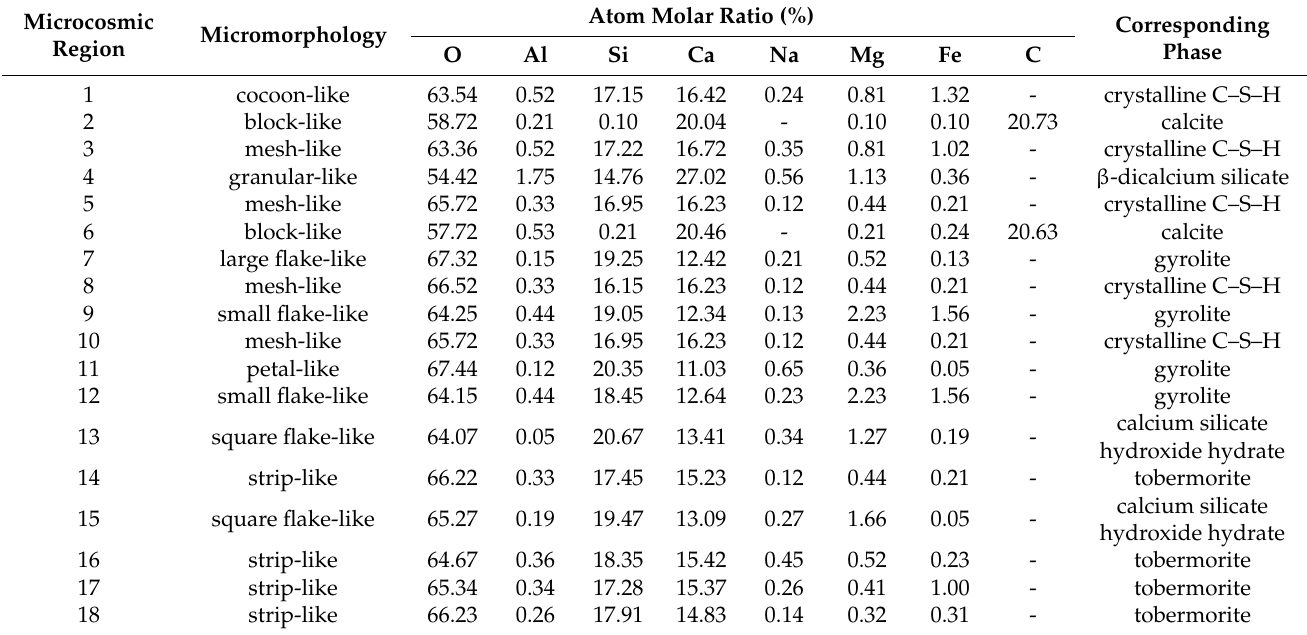
Table 3. EDS analysis results for different microcosmic